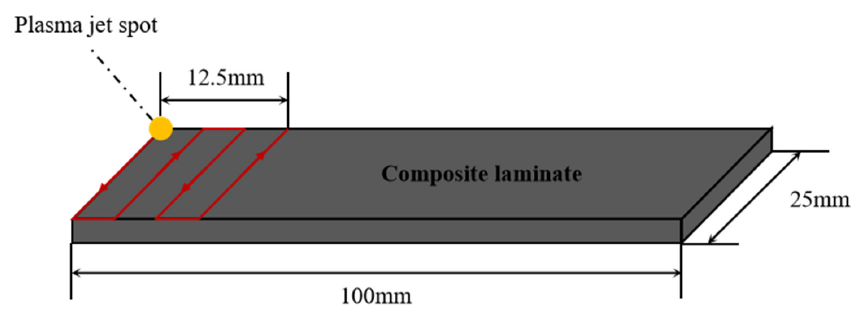
Figure 3. Schematic diagram of the motion path of plasma jet on composite laminates.